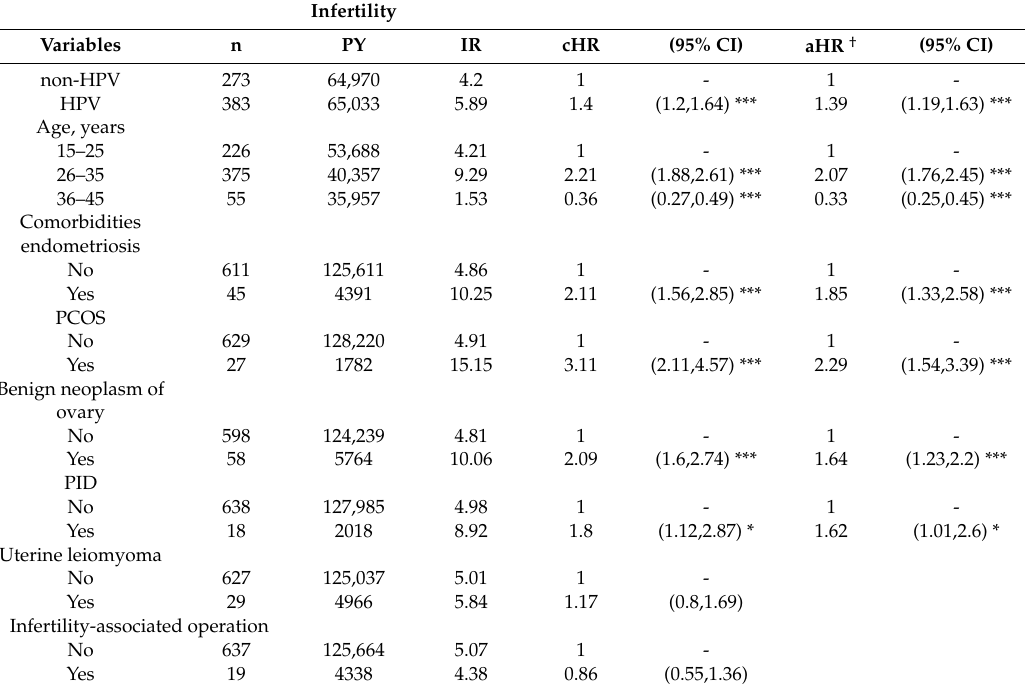
Table 2. Incidence rate and hazard ratio of